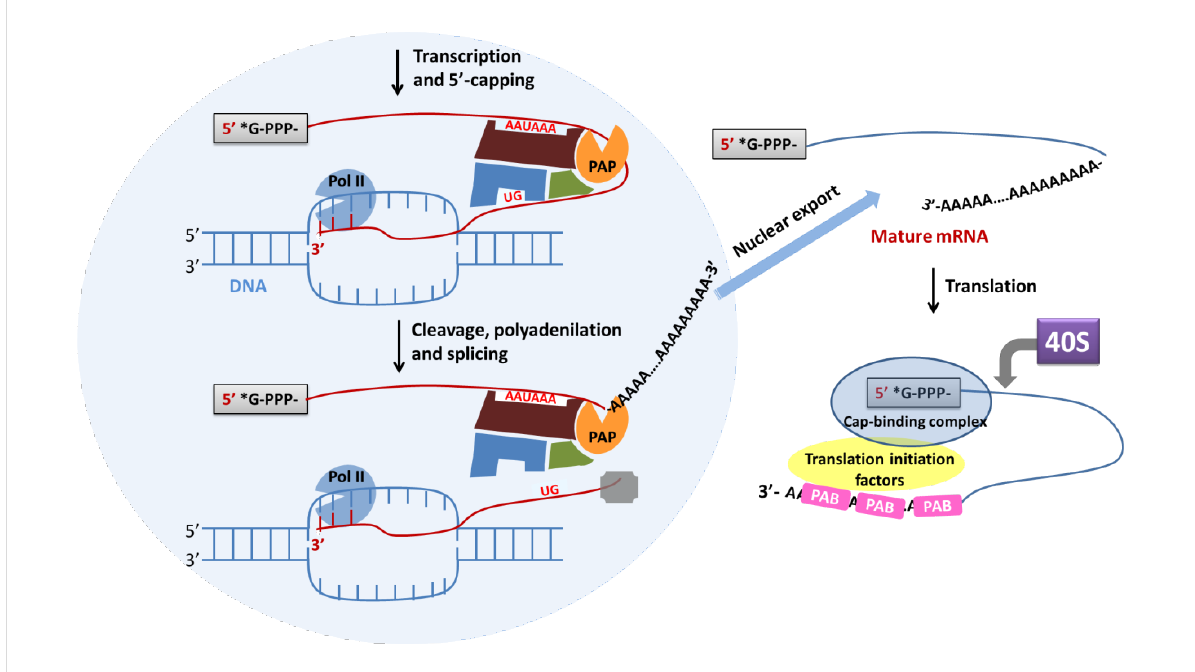
Figure 1: Schematic representation of transcription and translation–initiation processes in eukaryotic cells. The poly(rA) tail, added to the 3'-end of the pre-mRNA during transcription in the nucleus of eukaryotic cells, acts as the binding site in the cytosol for the polyA binding protein (PAB) which promotes translation. This recruits other proteins such as the translation initiation factor, 4G, which in turn engages the 40S ribosomal subunit.